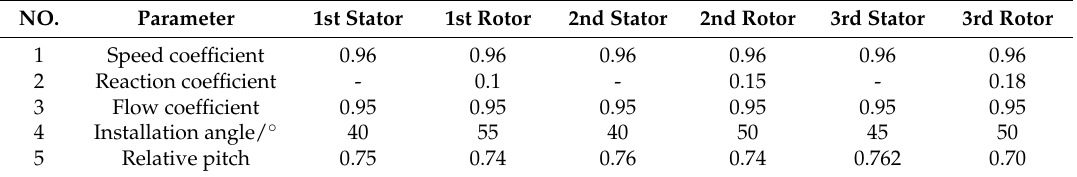
Table 2. Pre-fetched parameters.